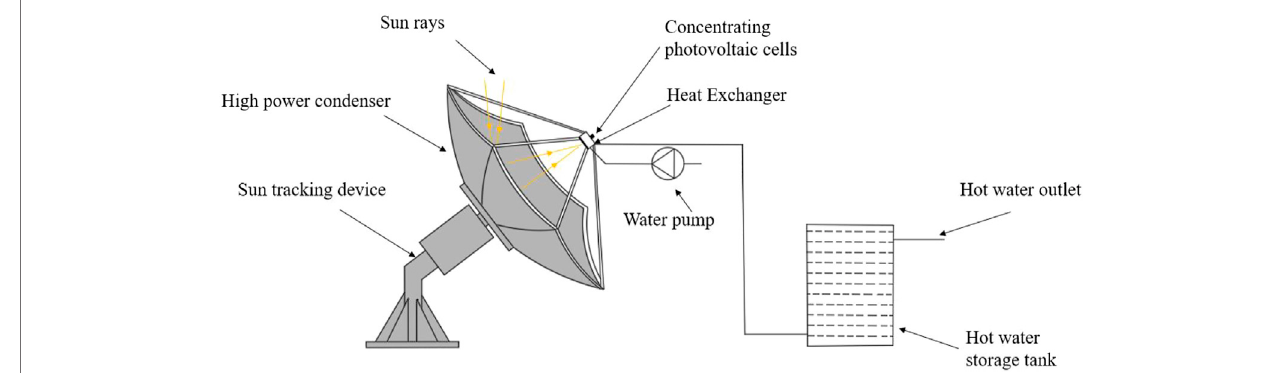
FIGURE 1 | A typical high-power concentrator system.